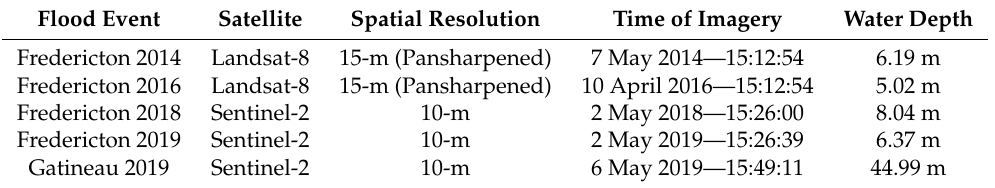
Table 1. Flood events and the satellites used for accuracy assessment in each